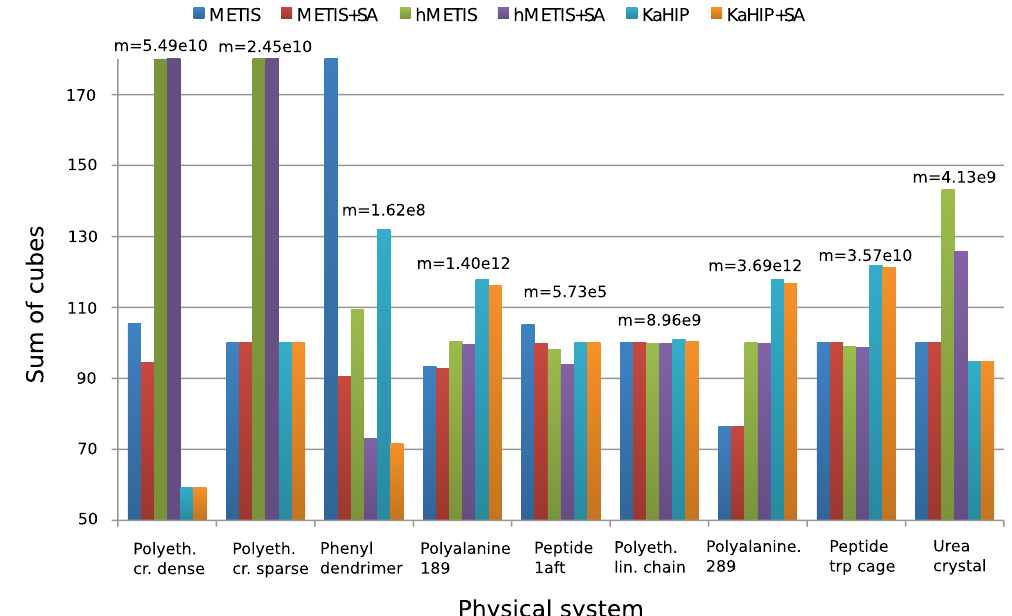
Figure 4. Sum of cubes performance measure to evaluate partitions. Values are normalized to have a median of 100. To make the chart more informative, very large values are truncated, though all exact values can be found in ([12], Table 2). Figure taken from [12]. Copyright c (cid:13) 2016 Society for Industrial and Applied Mathematics. Reprinted with permission. All rights